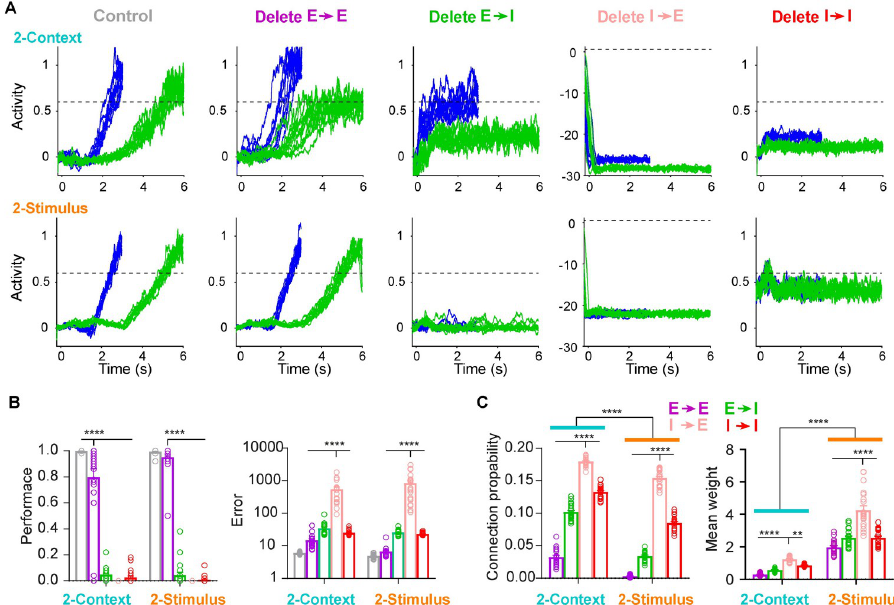
Fig 6. Differential connectivity patterns in RNNs trained on the 2-Context and 2-Stimulus tasks. ( A ) Example of the effects of deleting entire subgroups of synapses on performance in the 2-Context (top) and 2-Stimulus (bottom) tasks. From left to right, example output traces of the short (blue) and long (green) intervals for the control condition, and after deleting all excitatory unit to excitatory unit connections (Delete E ! E), all excitatory unit to inhibitory unit connections (Delete E ! I), all inhibitory to excitatory unit connections (Delete I ! E), and all inhibitory unit to inhibitory unit connections (Delete I ! I). (B) Mean performance (left) and error (right) of the outputs corresponding to the conditions in panel A . The performance for the Delete E ! E condition is significantly lower than the control but significantly higher than the other conditions in 2-Context task. For the 2-Stimulus task performance for Delete E ! E was not significantly worse than the control, but significantly higher than the other conditions (two-way ANOVA with mixed-effect design, F = 823.9, P < 0.0001, posthoc Tukey tests P < 0.0001). The error for Delete I ! E condition is 4 , 152 significantly higher than the other conditions in both 2-Context and 2-Stimulus task (two-way ANOVA with mixed- effect design, F = 39.8, P < 0.0001, posthoc Tukey tests P < 0.0001). (C) Left, connection probability in the 4 , 152 2-Context task was significantly higher than in the 2-Stimulus task(two-way ANOVA with mixed-effect design, F 1 , 38 = 338.3, P < 0.0001 for the task factor). Probability for the I ! E connections is significantly higher than that for the other three conditions: E ! E, E ! I, I ! I in both 2-Context and 2-Stimulus task ( F = 2884, P < 0.0001 for the connection 3 , 114 factor, posthoc Tukey tests P < 0.0001). Right, the mean weight in the 2-Context task is significantly lower than that in the 2-Stimulus task (two-way ANOVA with mixed-effect design, F = 219.1, P < 0.0001 for the task factor). 1 , 38 Probability for the I ! E connection is significantly higher than that for the other three conditions: E ! E, E ! I, I ! I in both 2-Context and 2-Stimulus task ( F = 183.7, P < 0.0001 for the connection factor, posthoc Tukey tests). ���� = P 3 , 114 < 0.0001, and �� = P = 0.002.